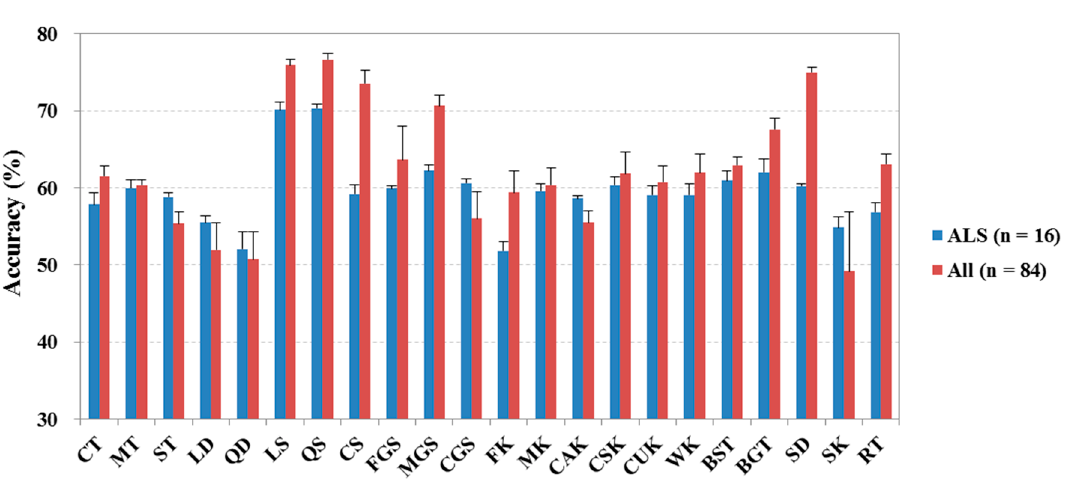
Figure 6. Classification accuracy of the 22 algorithms using 16 and 84 sub-datasets randomly selected from the 17 ALS-derived data and all 23 features, respectively. CT, complex tree; MT, medium tree; ST, simple tree; LD, linear discriminant; QD, quadratic discriminant; LS, linear SVM; QS, quadratic